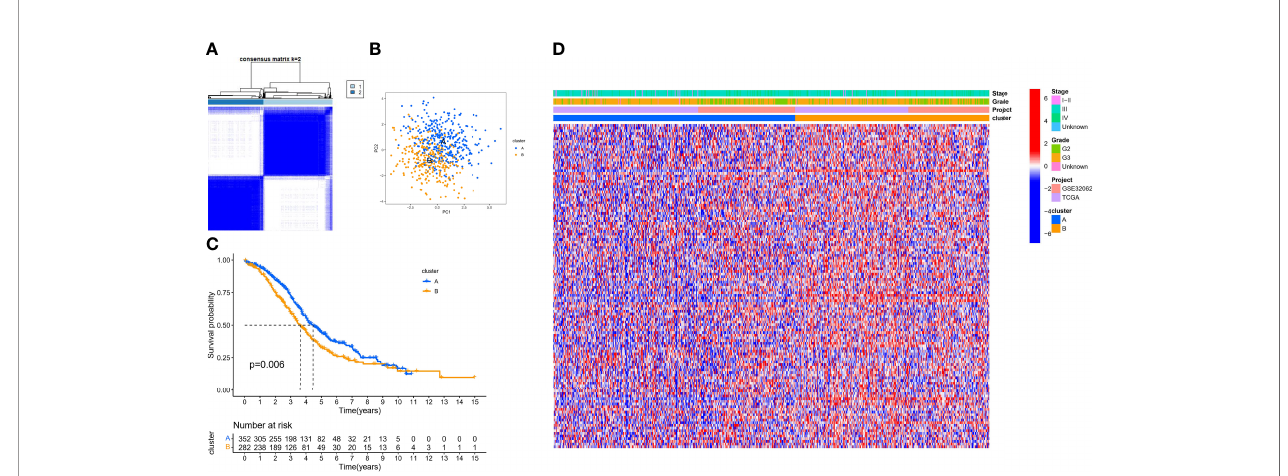
FIGURE 3 | The different hypoxia patterns in patients with OC. (A) Heat map of unsupervised clustering analysis. (B) Principal component analysis (PCA) analysis of different hypoxia patterns. (C) Kaplan – Meier analysis of overall survival time in different hypoxia patterns. (D) Heat map of the distribution of clinicopathological characteristics and two hypoxia patterns.